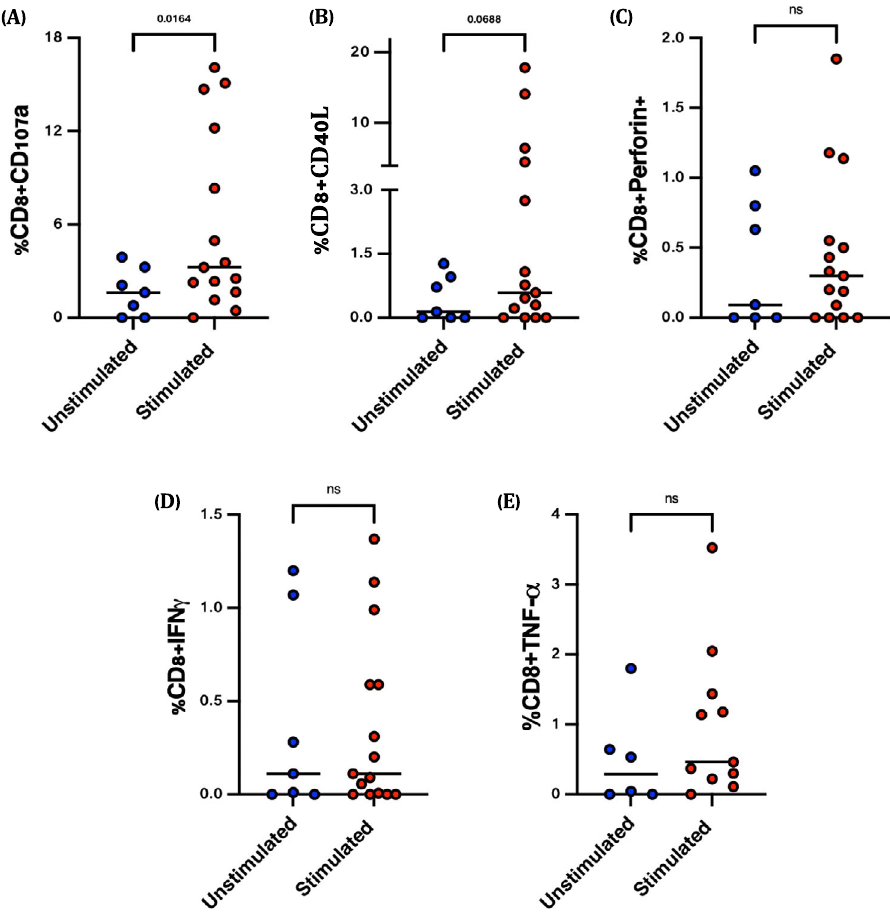
Fig. 3 SARS-CoV-2 spike-speci fi c CD8 + T cell responses ~2 months post-vaccination. Nasal immune cells isolated from individuals, approximately 2 months post second vaccine dose, were stimulated ( n = 15) with overlapping spike peptides (Red dots) or left unstimulated ( n = 7) (Blue dots). Frequencies of ( A ) CD107a, ( B ) CD40L, ( C ) Perforin, ( D ) IFN- γ and ( E ) TNF antigen-speci fi c CD8 + T cell responses. Unpaired non-parametric Mann – Whitney test was used (ns: non-signi fi